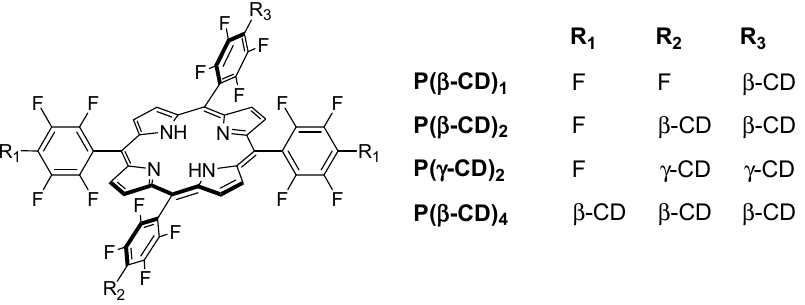
Figure 20. Chemical structure of porphyrin–CD conjugates (P(CD) x ).